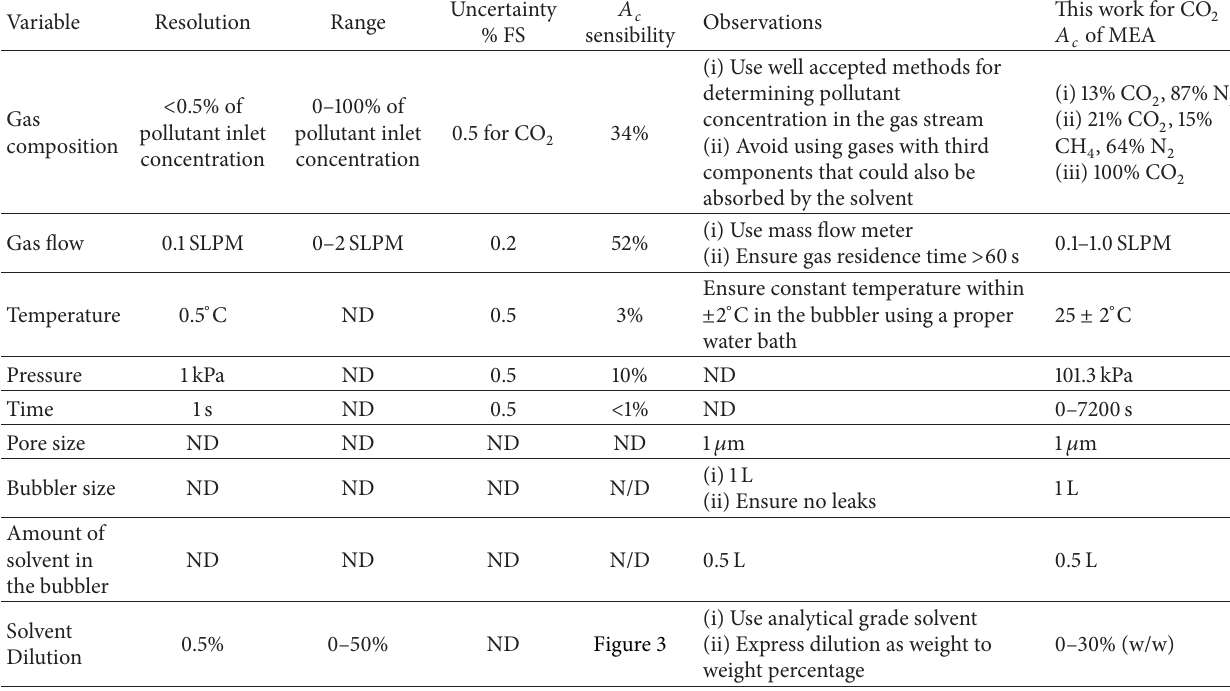
Table 1: Recommended values for variables to be monitored during bubbling tests.